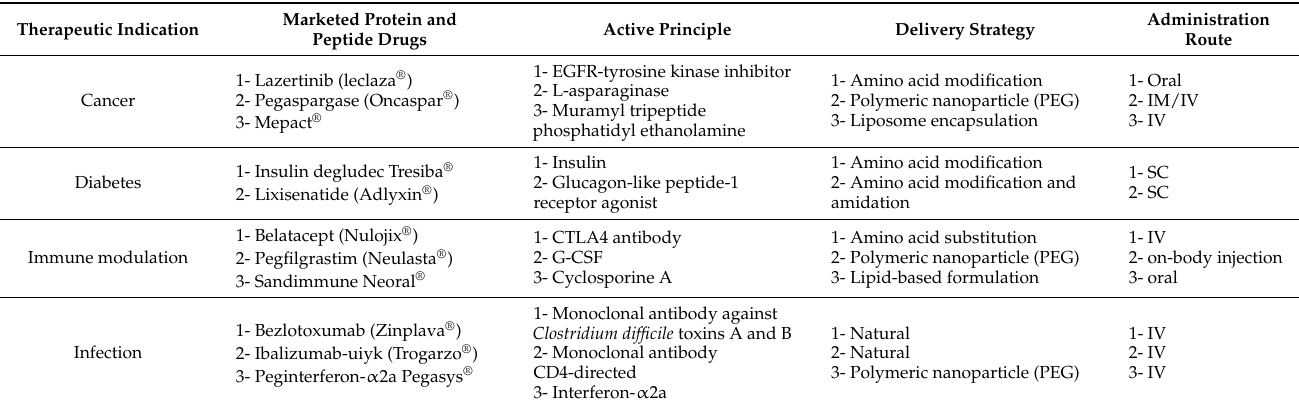
Table 2. Representative non-nano- and nano-delivery systems for protein/peptide drugs approved by the American Food and Drug Administration or European Medicines Agency to treat health